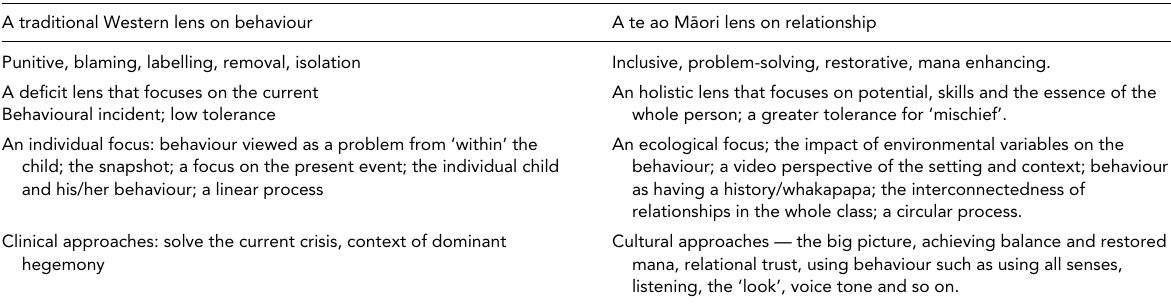
and his/her behaviour; a linear process Clinical approaches: solve the current crisis, context of dominant